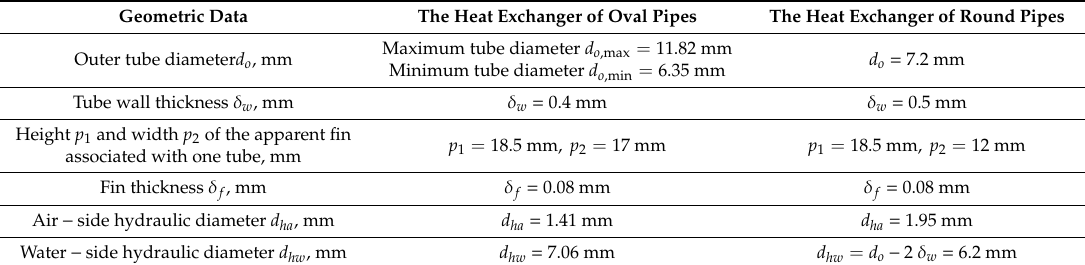
Table 1. Characteristics of finned tubes in the heat exchanger from oval and round